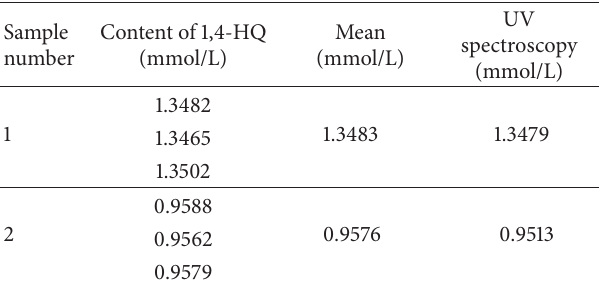
Table 1: Result of hydroquinone determination ( 𝑛 = 3